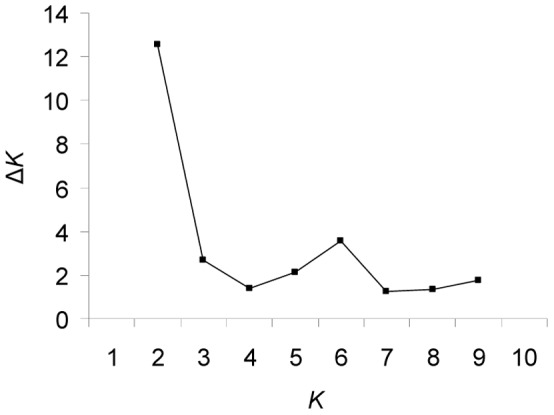
Estimation of the number of genetic clusters using Bayesian assignment technique.Second-order rate of change in the probability between successive runs (ΔK) as a function of K (number of clusters).